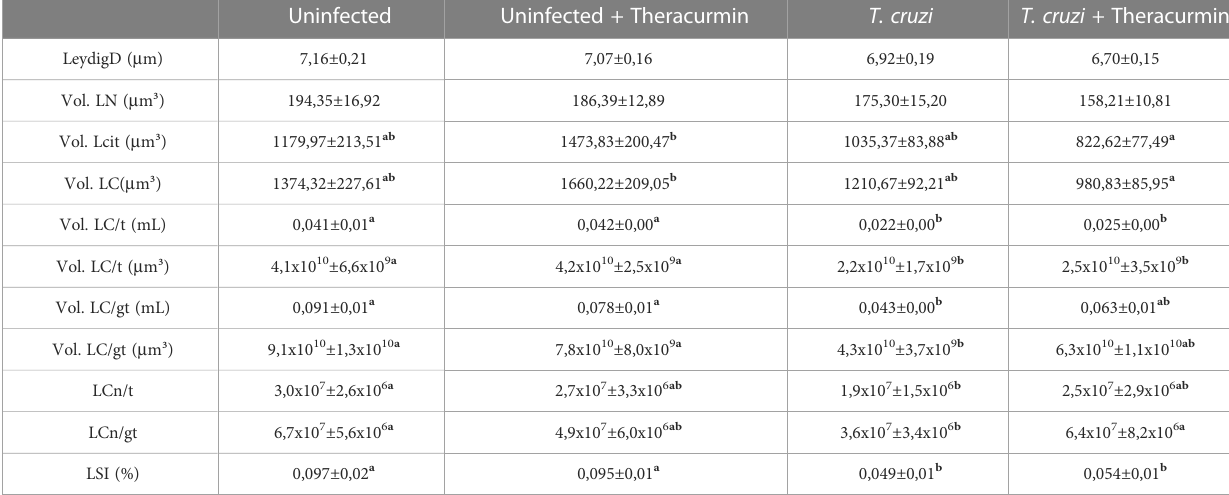
TABLE 5 Morphometric and stereological parameters of Leydig cells in mice infected with T. cruzi and treated with